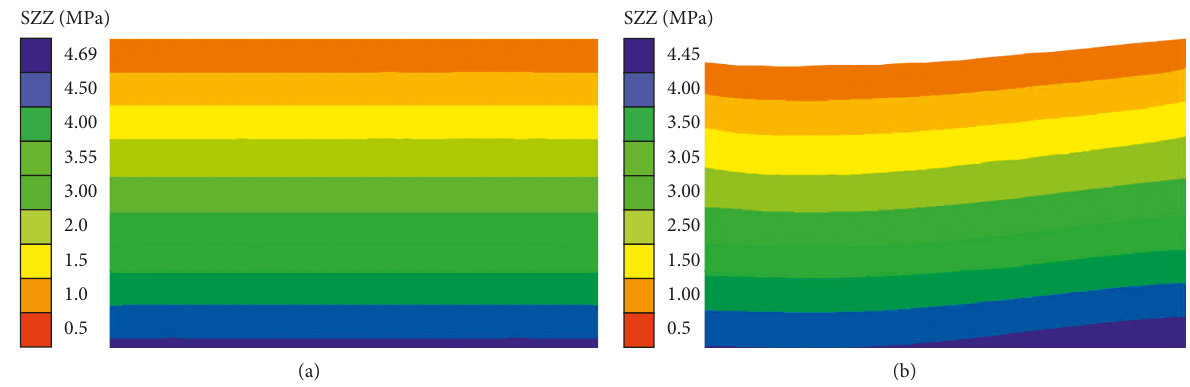
Figure 3: Stress cloud map of the stress field in the z direction: (a) before modification and (b) after modification.